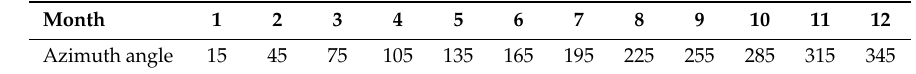
Table 1. Azimuth angle of each